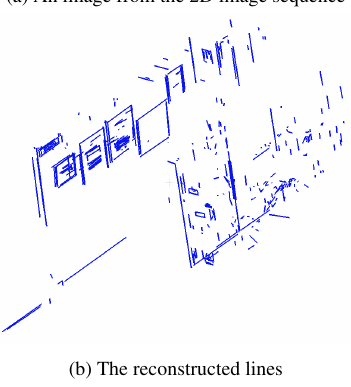
Figure 2. 3D line segments detection from an indoor scan